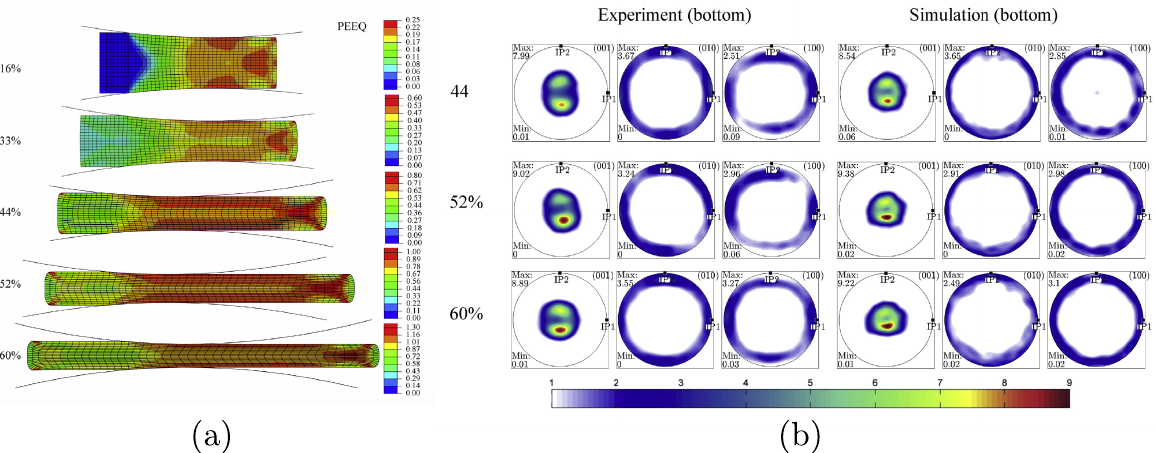
Figure 11. Simulation results of rolling test for the uranium α -U: ( a ) equivalent plastic strain contours at different step; ( b ) comparison between measured and predicted evolution at a polycrystalline material point near the bottom surface of the plate. Reproduced from [182], under